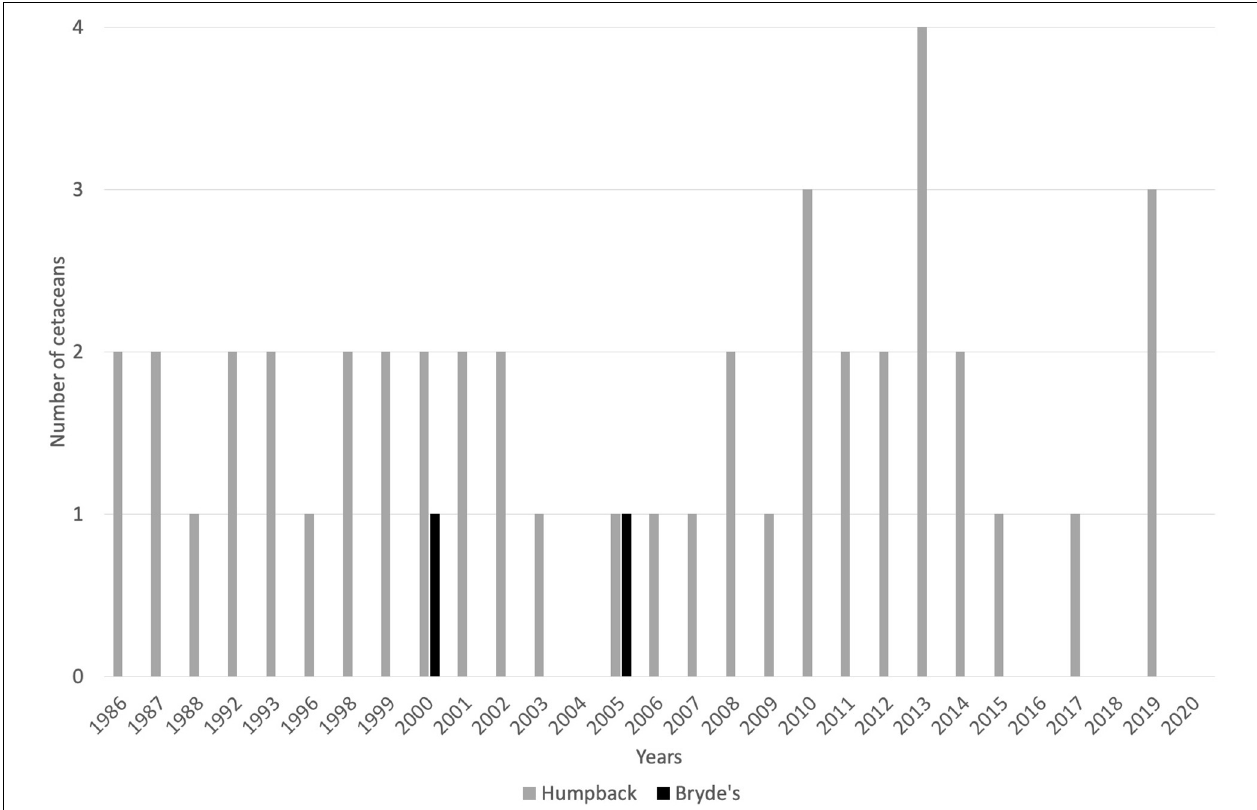
FIGURE 5 | Catch records for IWC-protected whales taken by whalers based at Bequia and Barrouallie, SVG, for the period 1986–2020. Gaps represent zero cetaceans taken. Source: IWC (2021). Not included is the occasional, unreported take of sperm whales by Barrouallie-based whalers.